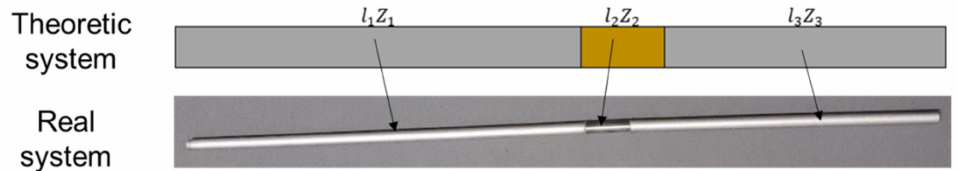
Figure 3. The ternary system. Legend: l 1 , l 2 , l 3 represent the length of each rod; Z 1 , Z 2 , Z 3 is the acoustic impedance of